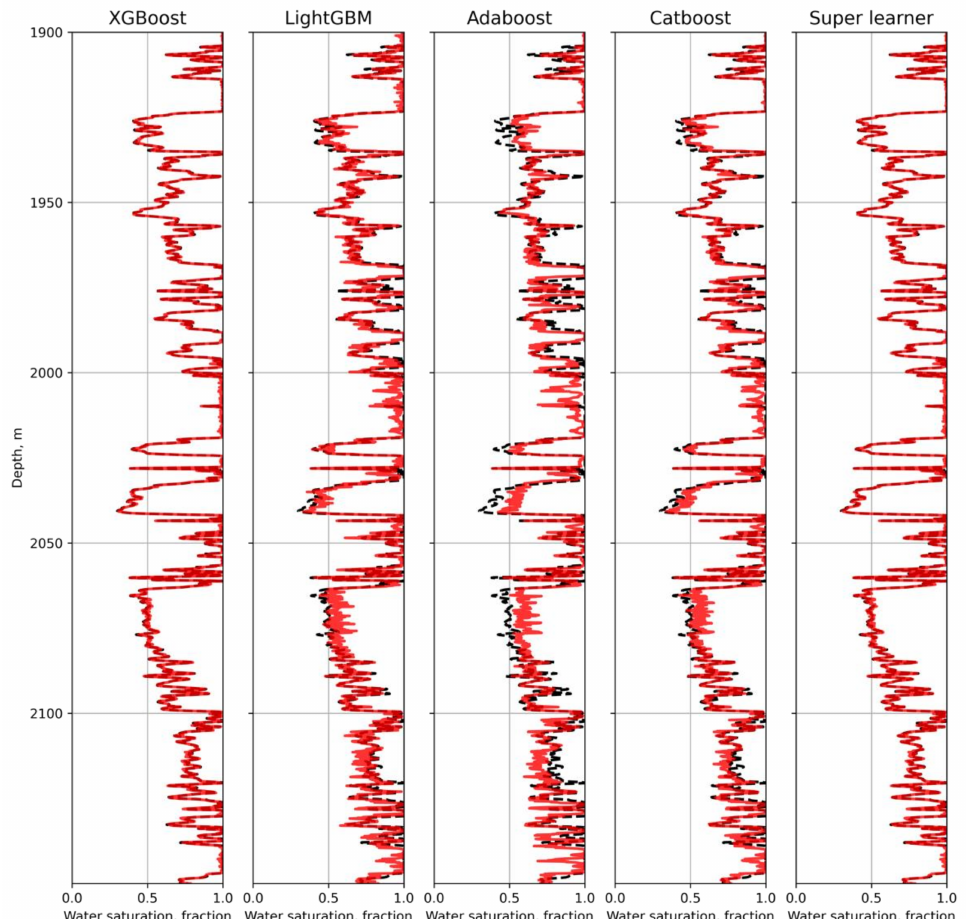
Figure 8. Water saturation well log prediction results by different algorithms for one representative well from dataset A. In this figure, the red curve represents predicted values, and the black line is target values. It is seen that a perfect match is obtained via Super Learner method. Table 4. Evaluation metrics summary for dataset B where PEF log is kept out of the analysis/predictions.